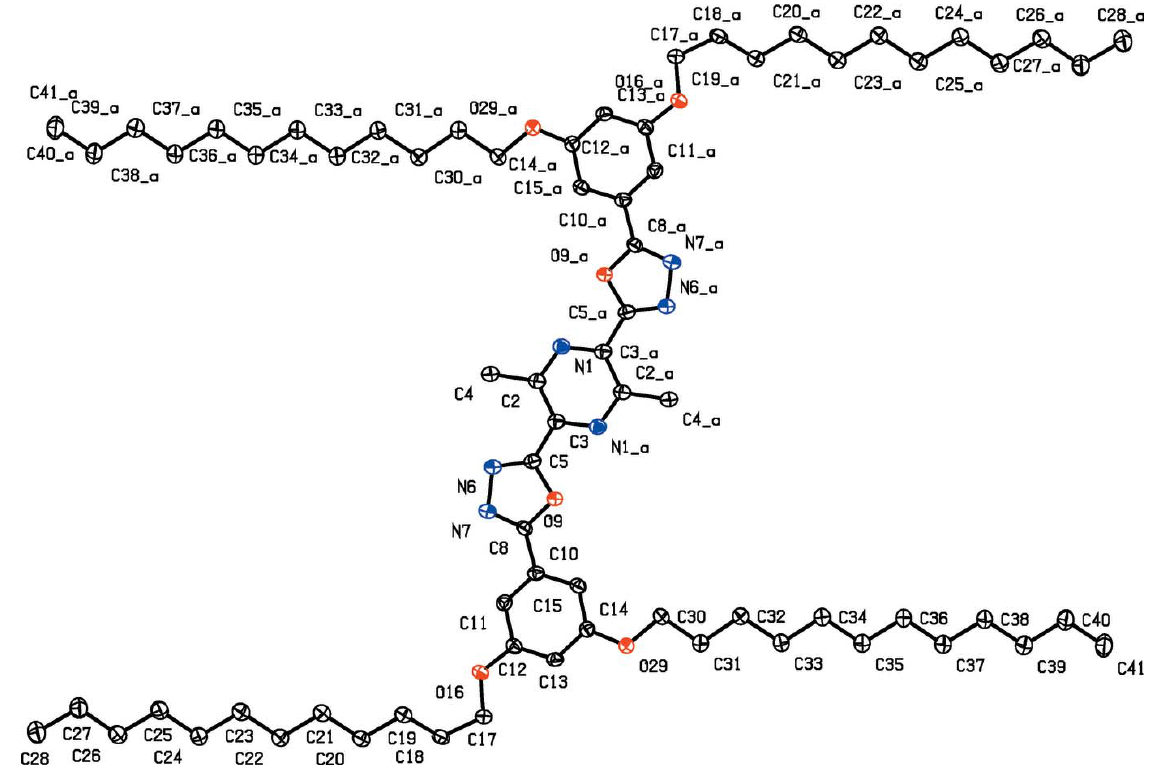
Figure 1 View of the title compound. Displacement ellipsoids are drawn at the 50% probability level. Atoms with suffix _a were generated by the symmetry